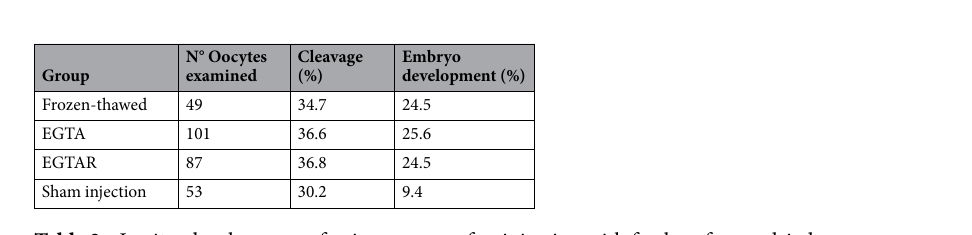
Table 2. In vitro development of ovine oocytes after injection with fresh or freeze-dried